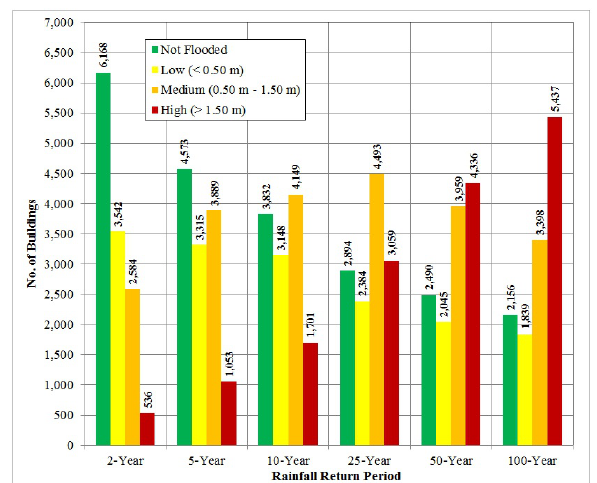
Figure 9: Number of affected buildings for each of the 6 extreme rainfall events.